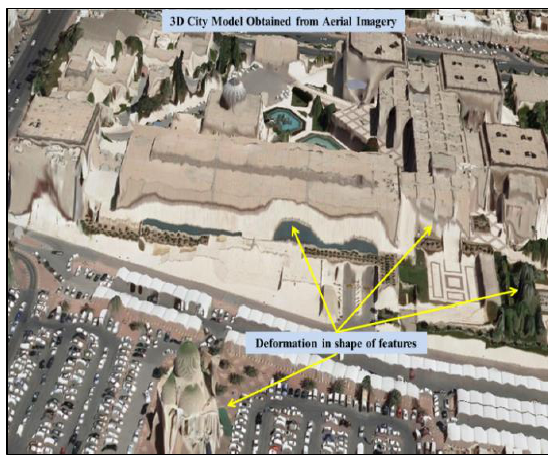
Figure 8. 3D texture obtained from aerial imagery (a).